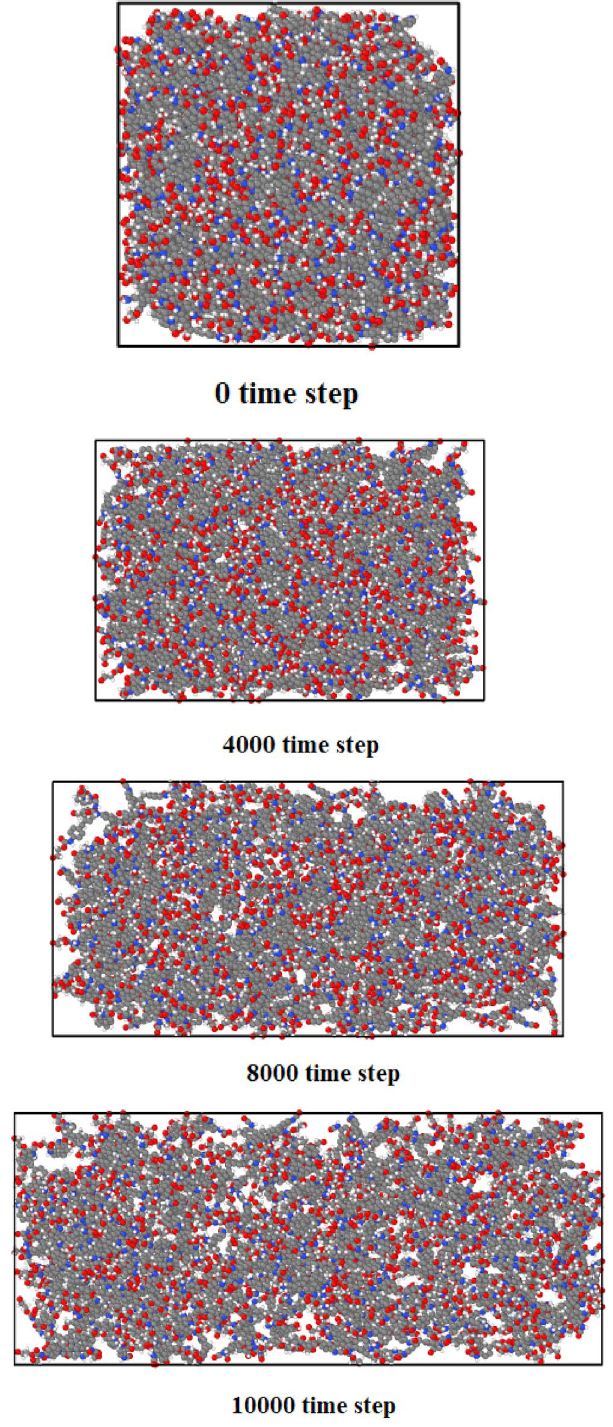
Figure 5. Mechanical traction process of concrete in the initial time